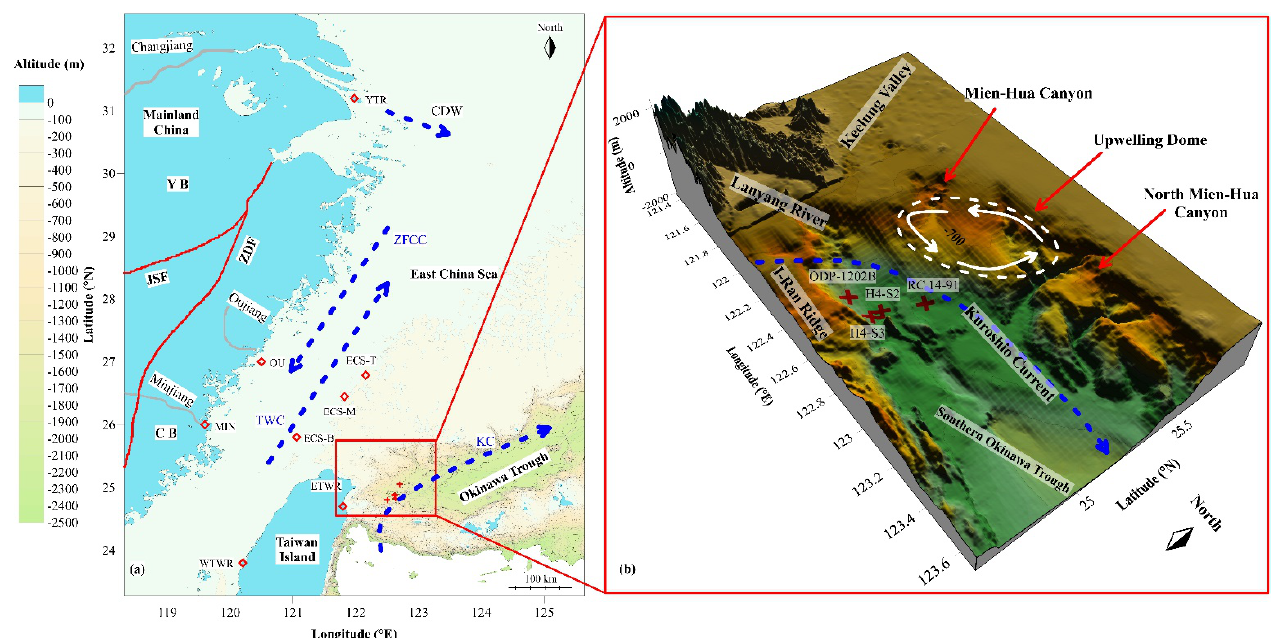
Figure 1. ( a ) Currents, cores, and potential provenance areas distribution in the East China Sea (modified from references [5,8,26,33–35]), and ( b ) the location of cores in the Southern Okinawa Trough. YTR, the Yangtze River (Changjiang) mouth; OU, Oiujiang; MIN, Minjiang; ECS-T, ECS-M, and ECS-B, East China Sea shelf; WTWR, Zhuoshui river mouth; ETWR, Lanyang river mouth. CDW, Changjiang Diluted Water; ZFCC, the Zhejiang-Fujian Coastal Current; TWC, the Taiwan Warm Current; KC, Kuroshio Current. Y B, the Yangtze Block; C B, the Cathaysia Block; JSF, Jiang-Shao Fault; ZDF, Zhenghe-Dapu Fault. The location of upwelling dome, valley, ridge, and canyon modified from reference [8]. The pathways of currents and upwelling dome in this figure are not a representation of the actual location. The potential provenance areas are represented by red diamonds, with specific latitude and longitude from the references [6,33,36,37]. Cores in the Southern Okinawa Trough are represented by red crosses, with specific locations from the references [8,10,12]. Topographic data comes from https://www.gebco.net/ (accessed on 2 December 2021).